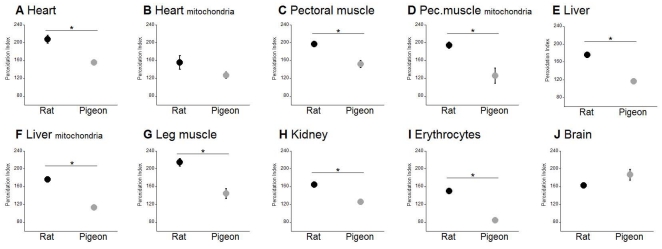
The peroxidation index (PI) of rat and pigeon tissues and mitochondria.The PI describes the susceptibility of membranes to damage by reactive oxygen species. It is calculated taking into account the combination of the relative susceptibilities of different fatty acids to peroxidation. Shown are means ± SEM, n = 6 for rats and n = 8 for pigeons (besides heart mitochondria where n = 3 for rats and n = 5 for pigeons, and brain where n = 3 for rats), Significant differences are highlighted with an asterisk (p<0.01).